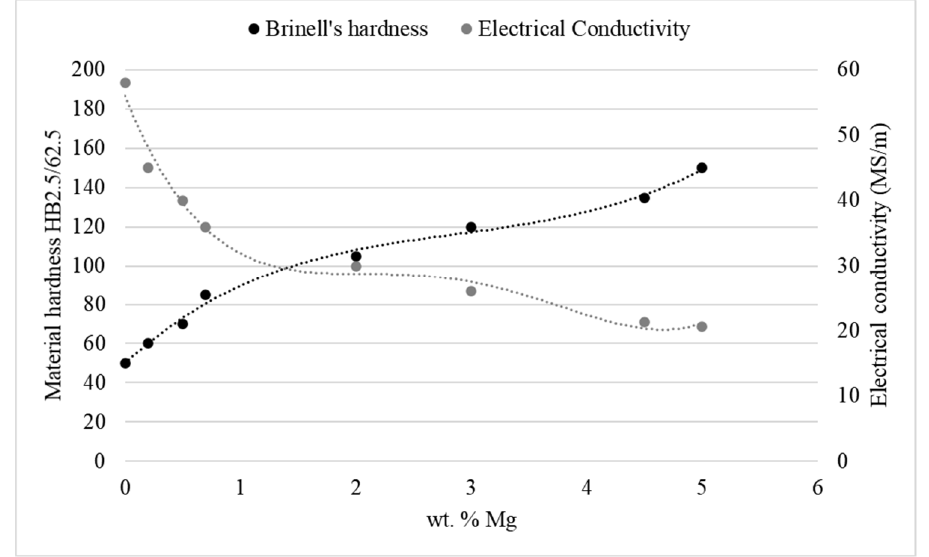
Figure 5. Known literature values [21,28,29] of hardness and electrical conductivity of CuMg alloys put together collectively with research results .